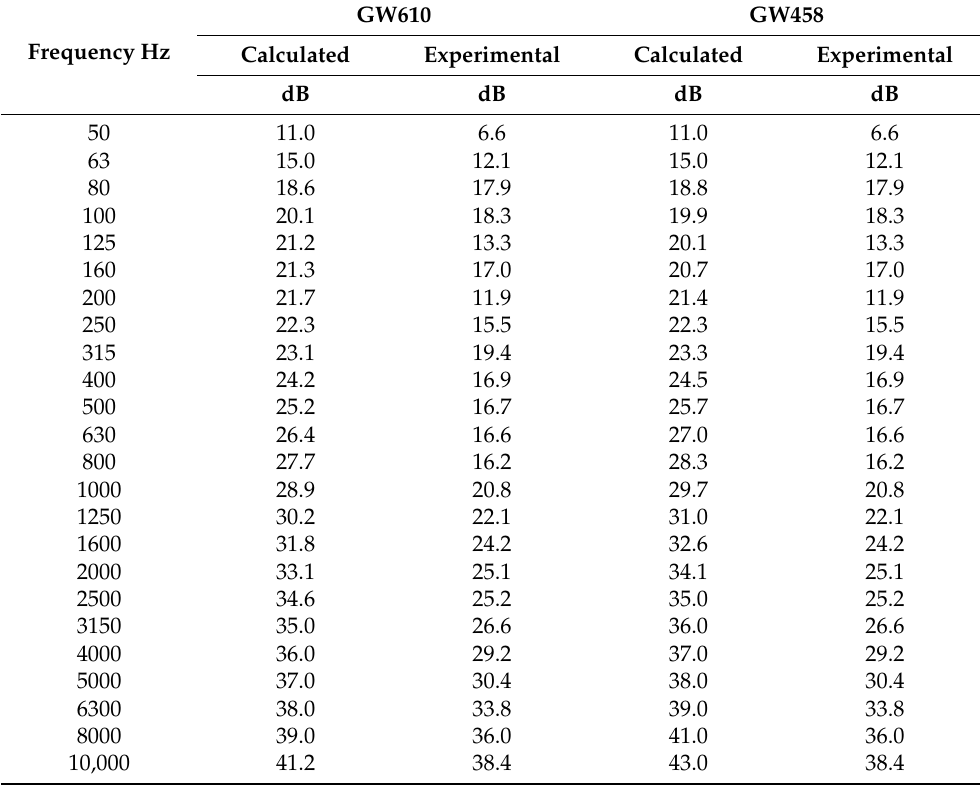
Table 5. Measured and predicted transmission loss for GW580 and GW700 PVC panels.